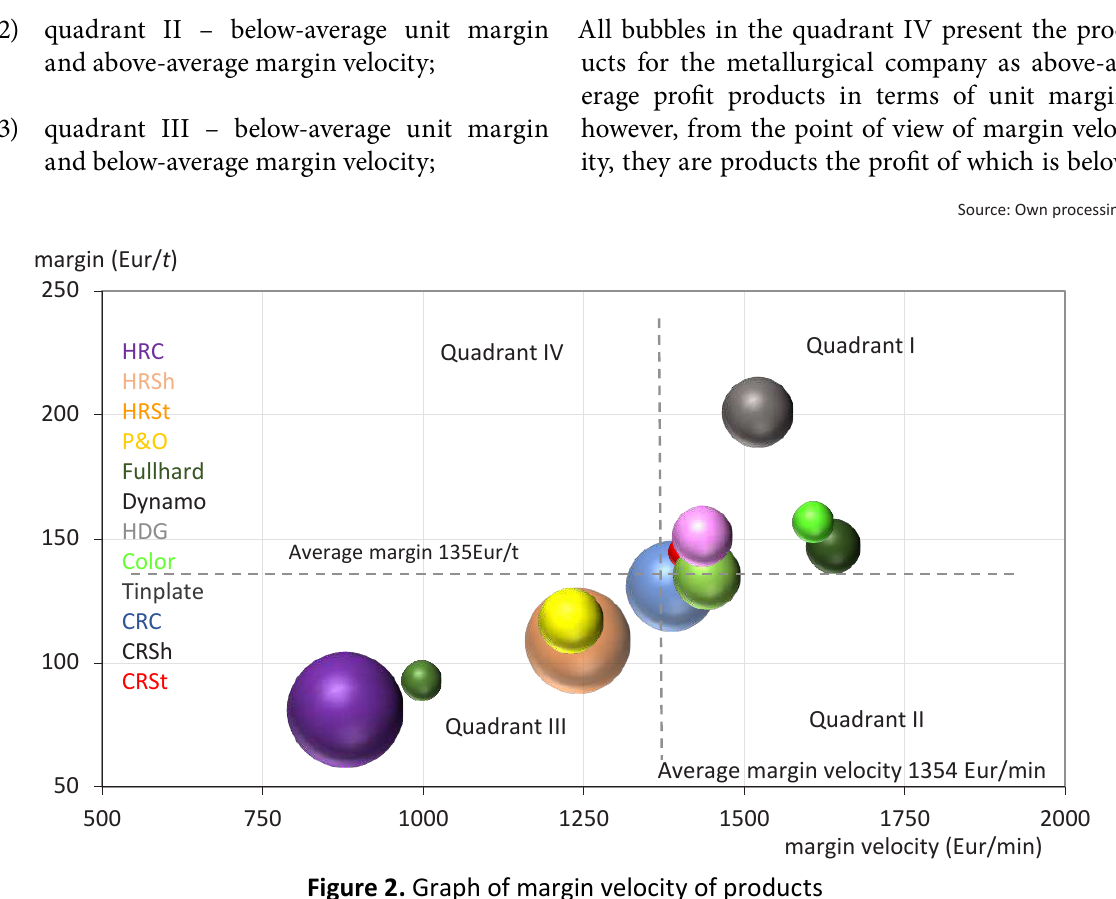
Figure 2. Graph of margin velocity of products